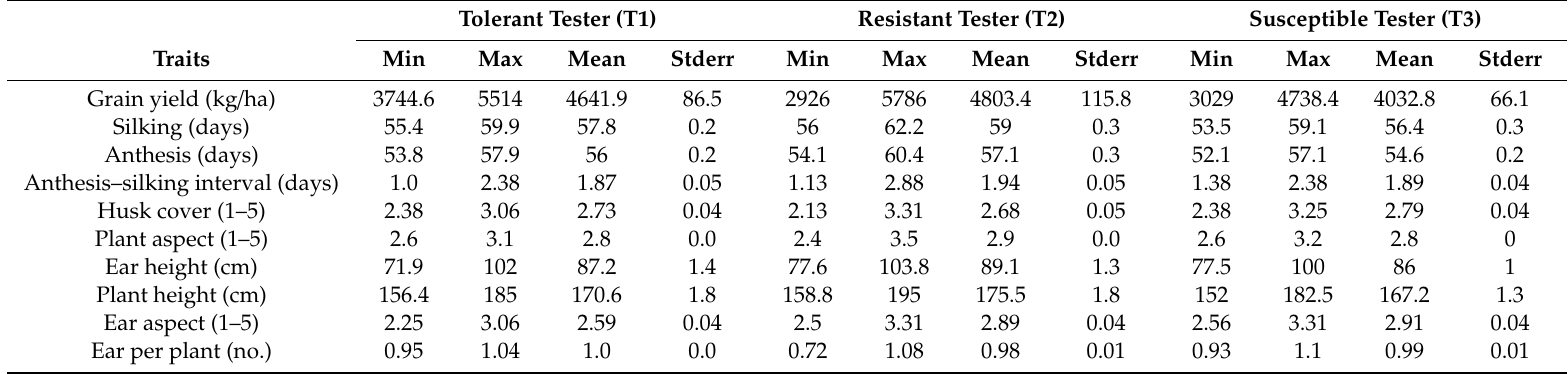
Table 5. Means, maximum, minimum and standard error (Stderr) of agronomic traits for the testcrosses of yellow maize from three testers under the Striga -non-infested condition across four